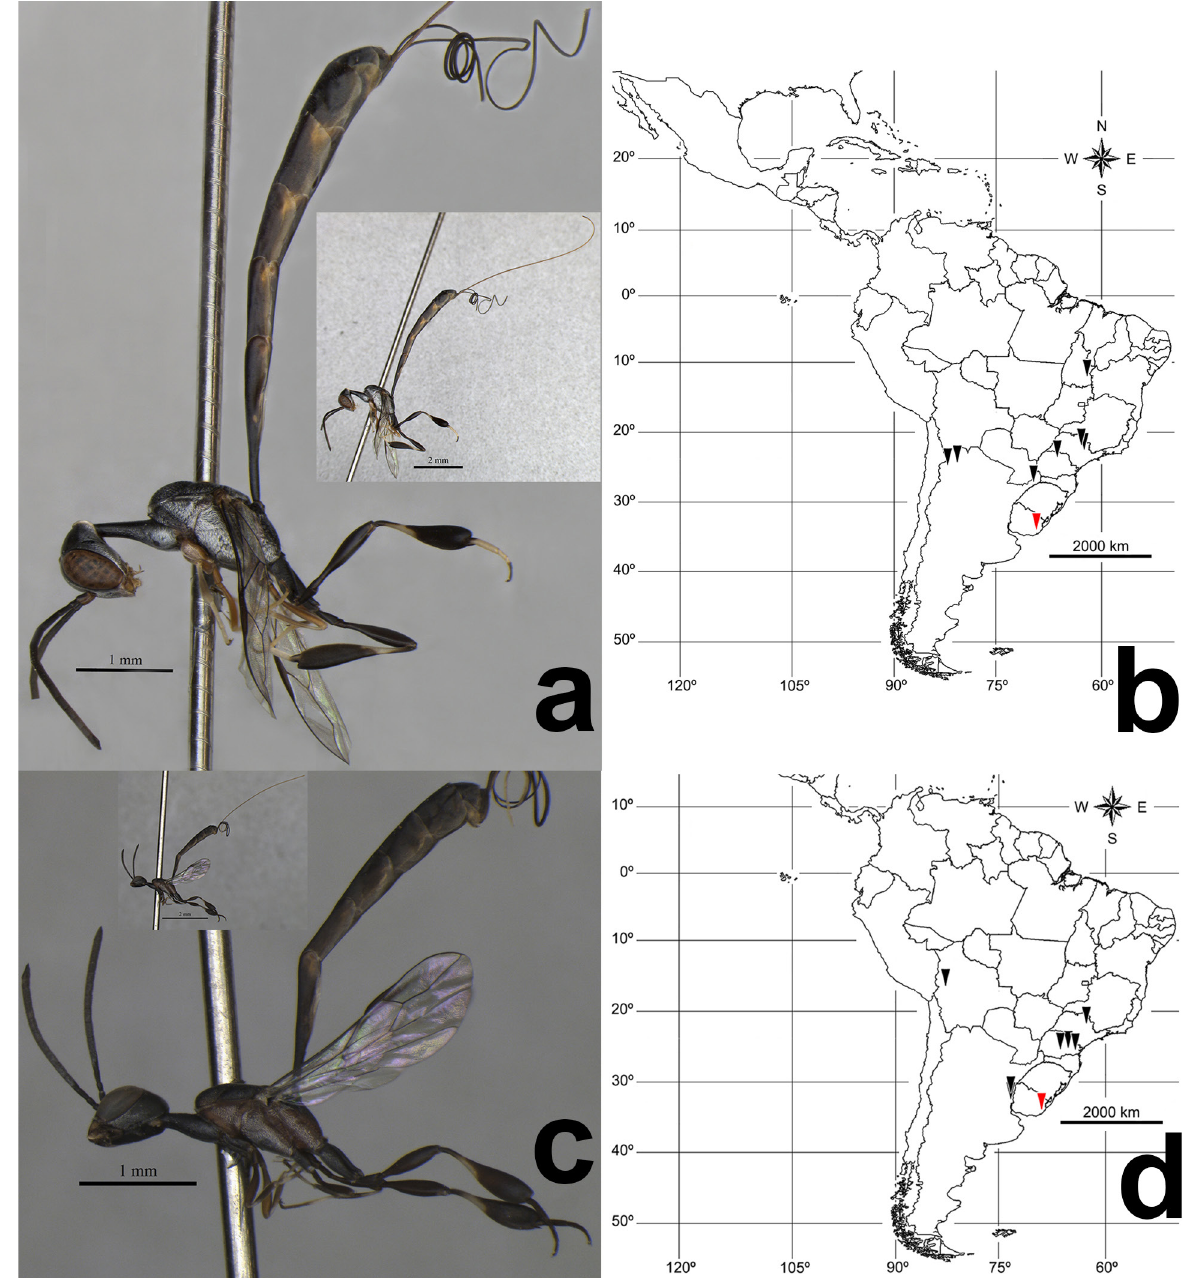
Figures 2. a. Gasteruption brandaoi Macedo, 2011, 1906, female without ovipositor; in detail, habitus lateral. b. Map of known distribution of Gasteruption brandaoi Macedo, 2011. c. Gasteruption helenae Macedo, 2011, female without ovipositor; in detail, habitus lateral. d. Map of known distribution of Gasteruption helenae Macedo, 2011. Black triangles are previous records (Macedo 2011), the red ones new records to